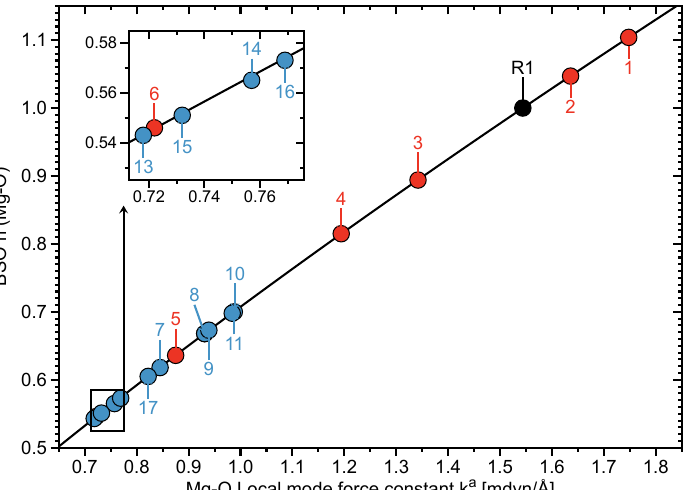
Figure 2. BSO n (Mg–O) values and Mg–O force constants k a for clusters 1 – 17 and R1 calculated at the ω B97X-D/6-311++G(d,p) level of theory. BSO n (Mg–O) values were calculated via Equation (6). R2 was excluded from the plot to improve the visibility of the data. Clusters 1 – 6 are represented by red points, clusters 7 – 17 are depicted by blue points, and the black point portrays the Mg–O molecule ( R1 ).